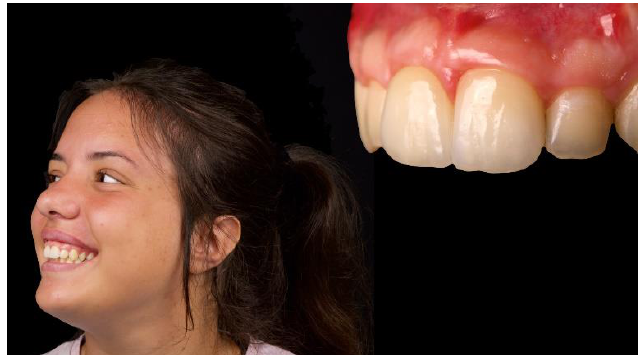
Figure 15. Intraoral front 1 year after implant placement (2 months after definitive-restoration delivery).